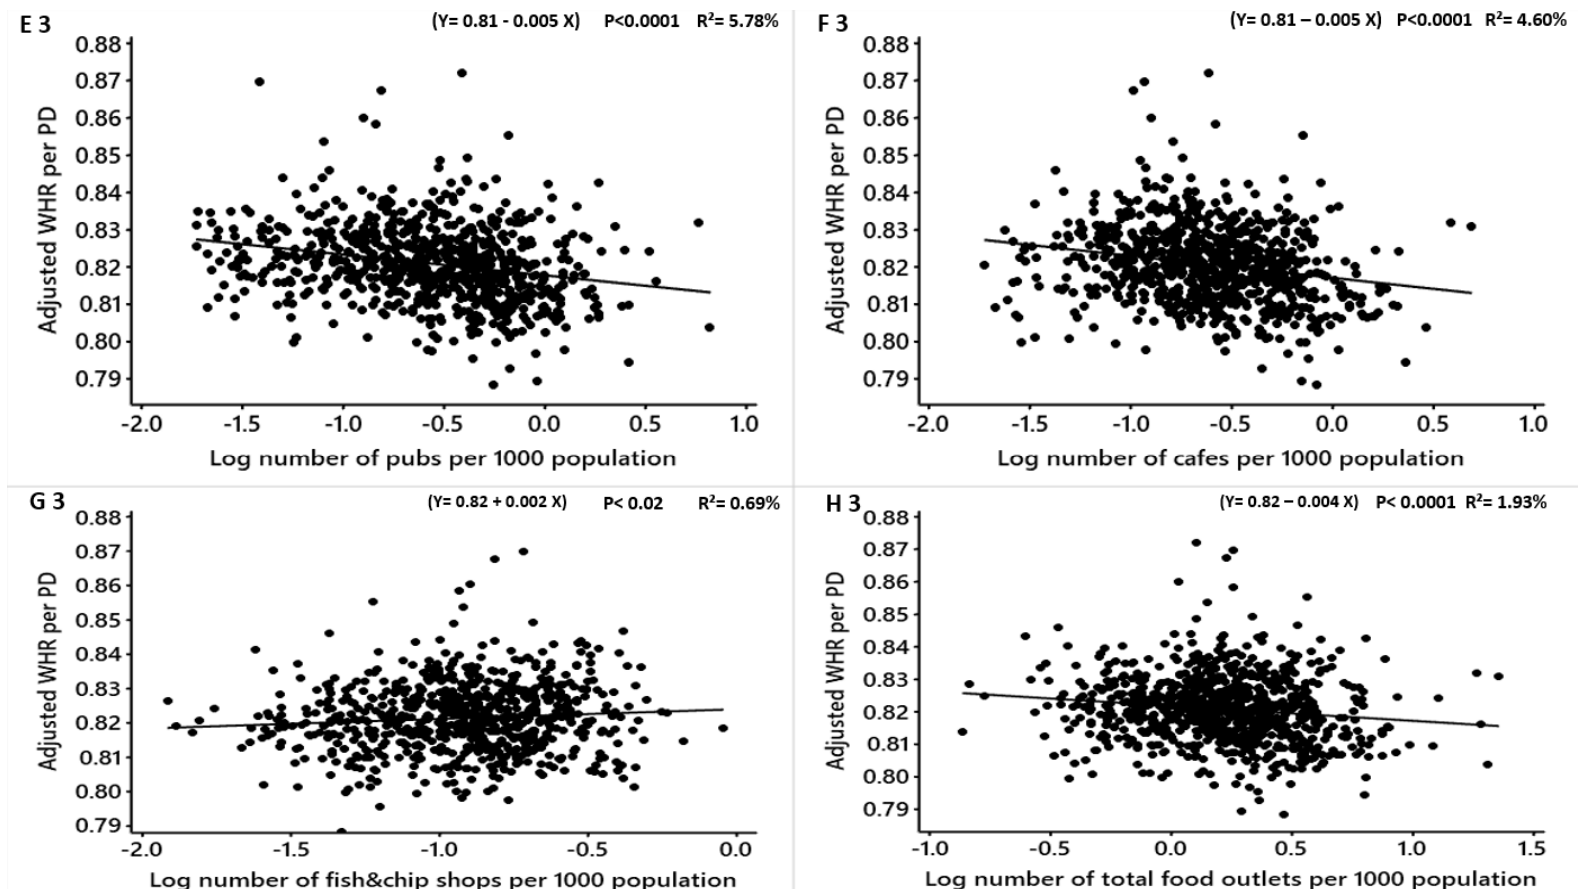
Figure 4: Females: Linear regression analysis of the association between log-transformed numbers of food outlets per 1000 population and adjusted obesity measures. Obesity measures adjusted for deprivation level per household, education, employment, ethnicity, household size, household income and age. BMI = Body Mass Index, WHR = Waist to Hip Ratio. FFR = Fast-Food Restaurants, FSR = Full-Service Restaurants, total food outlets = combined.